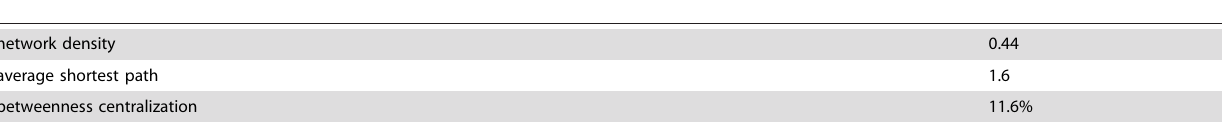
Table 1. The network of prior acquaintance between the group’s 22 participants.